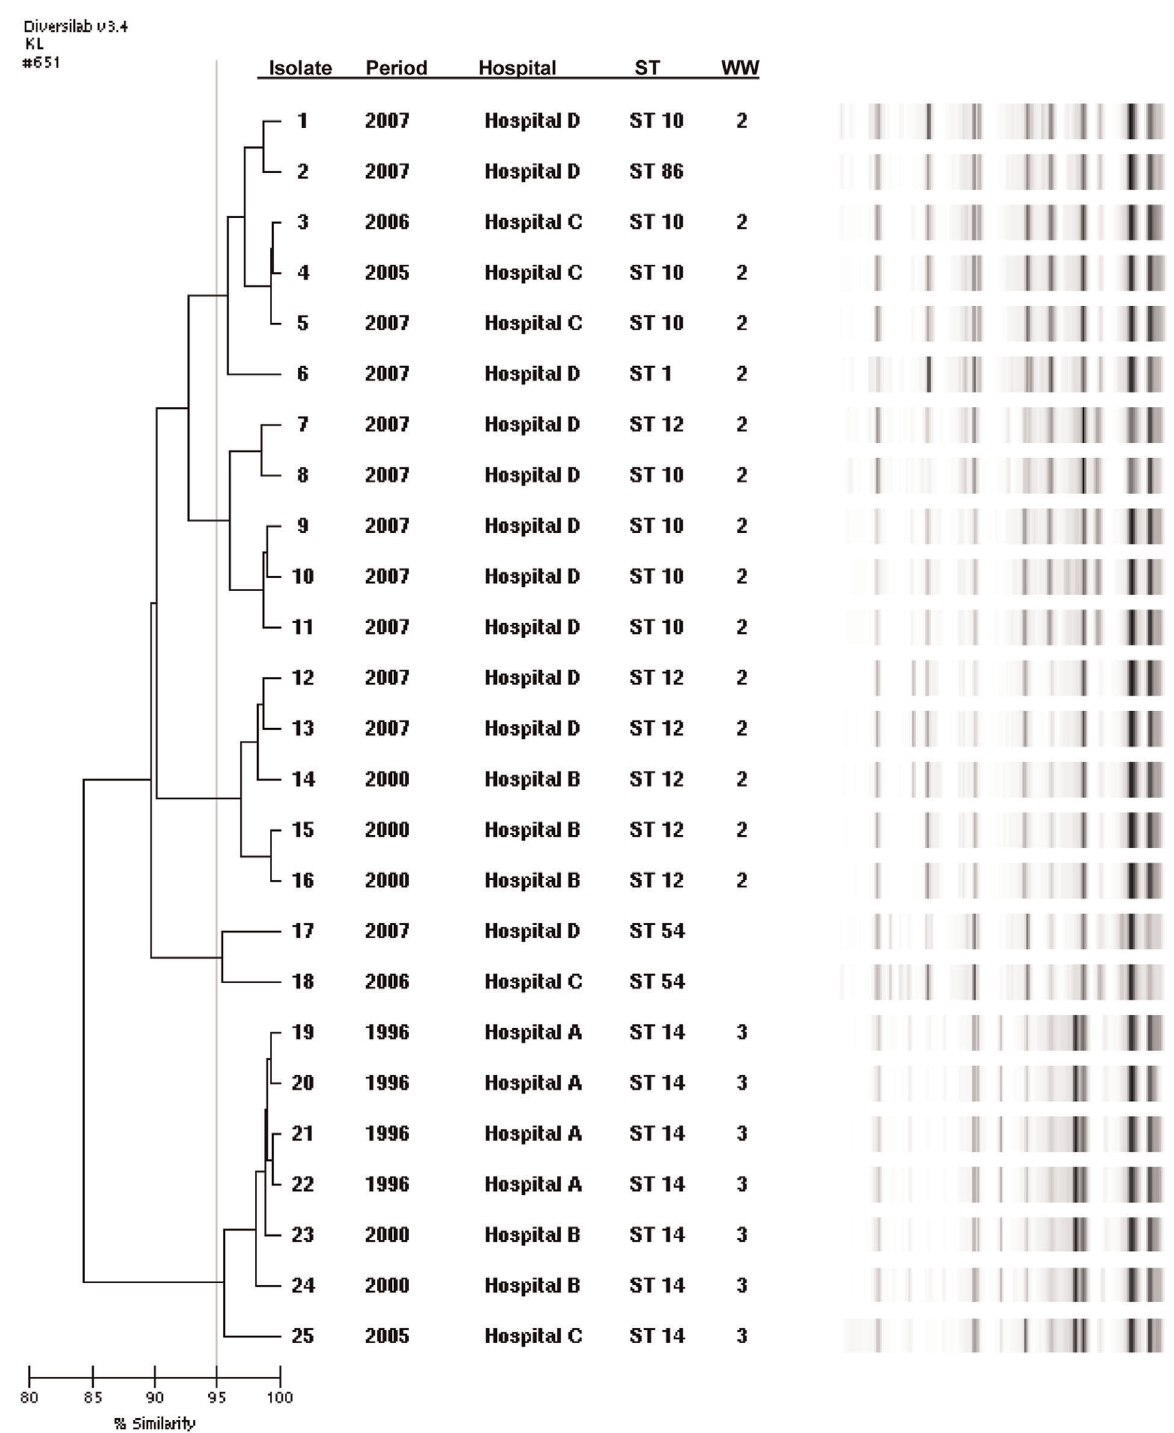
Figure 2. Genetic similarity among A.baumannii isolates. Representative A. baumannii isolates typed by rep-PCR, analyzed with the Kullback- Leibler method. Five strain types with . 95% similarity are illustrated, and further discriminated by year, hospital of origin, PCR-ESI/MS sequence type (ST), and worldwide (WW) clone types. doi:10.1371/journal.pone.0033443.g002 differentiation of isolates when performing molecular epidemiol- ogy studies comprising isolates of different years obtained from several hospitals.